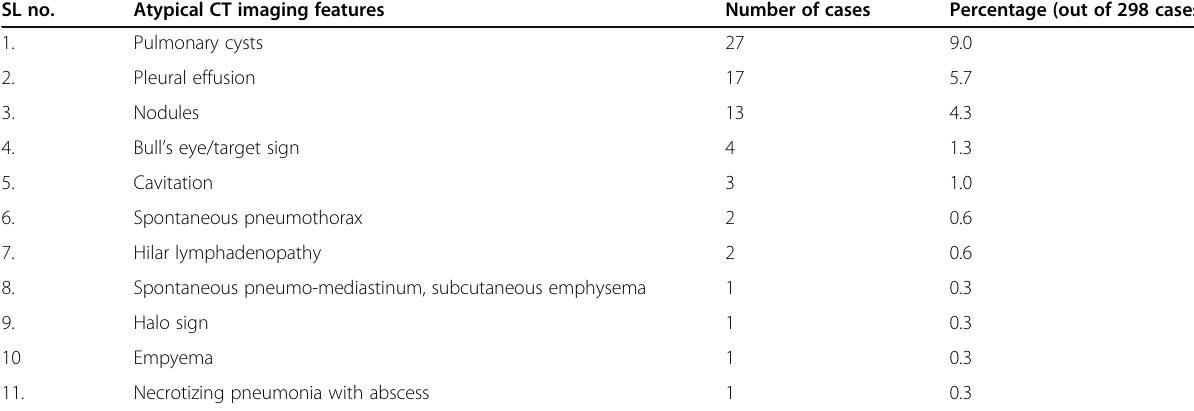
Table 1. The age group (51 – 60) had highest cases with total of 79 cases (26.5%) There was predilection for males 234 (78.5%) when compared to female 64 (21.5%). Table 4 Incidences of the atypical CT findings of COVID-19 among the study group SL